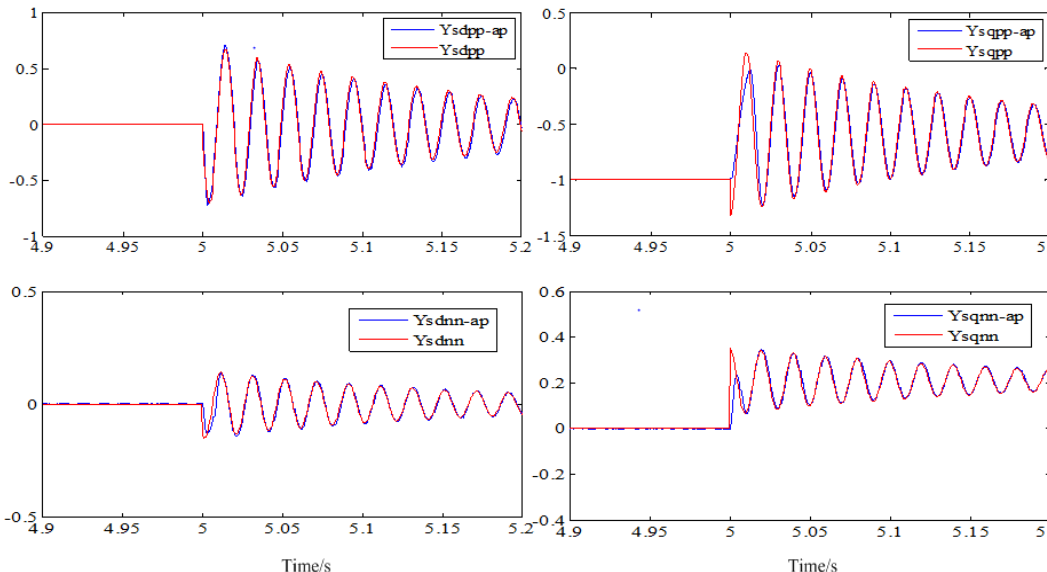
Figure 6. d -axis and q -axis components of the stator flux linkage in the ( dq ) + and ( dq ) − reference frames.